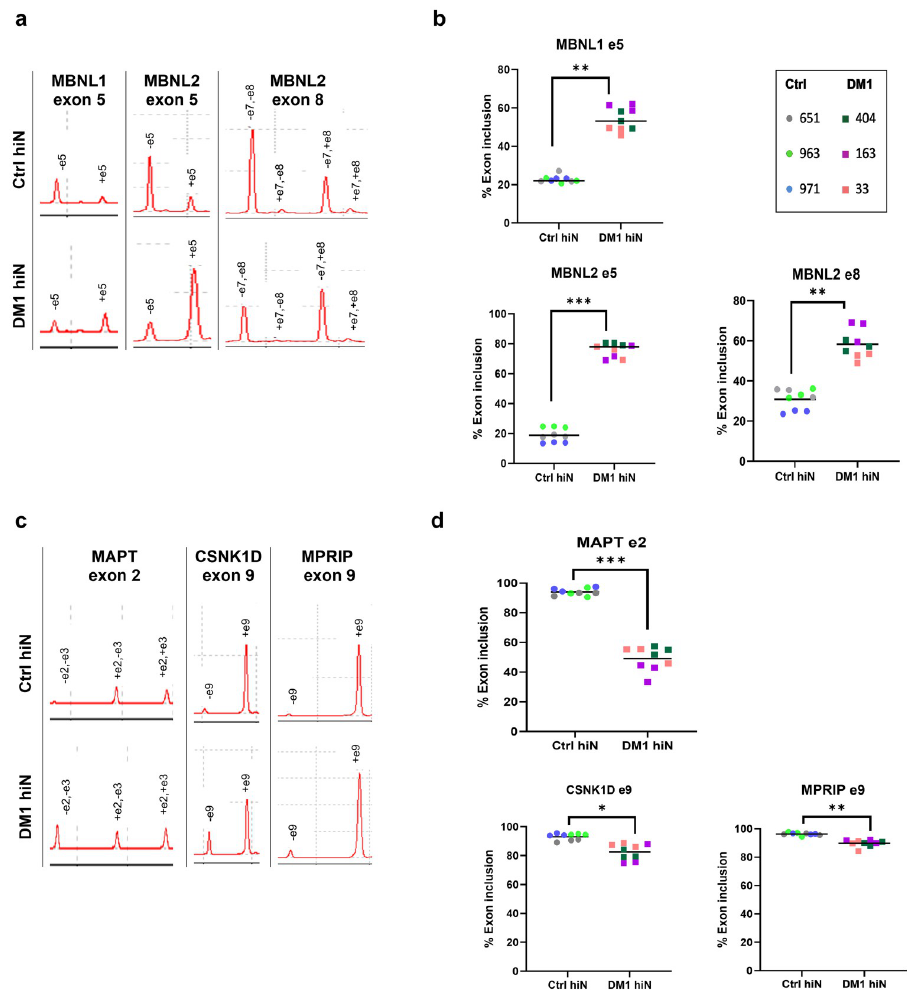
Fig 5. Dysregulated alternative splicing in DM1 hiNeurons at 10 DPI. (a) Electropherograms plot the results of RT-PCR products for MBNL 1 and 2 analyzed by MultiNA automated microchip electrophoresis system. Exon inclusion (+) or exclusion (-) of MBNL 1 e5 (left), MBNL 2 e5 (middle) and MBNL 2 e8 (right) in ctrl hiNeurons (top) vs. DM1 hiNeurons (bottom). (b) Scatter plots pertaining to Fig 5a show increased inclusion of MBNL 1 e5 (top), MBNL 2 e5 (bottom left) and MBNL 2 e8 (bottom right) in DM1 hiNeurons. (c) Electropherograms plot the results of RT-PCR products for some gene transcripts involved in neurite outgrowth. Exon inclusion (+) or exclusion (-) of MAPT e2 (left), CSNK1D e9 (middle) and MPRIP e9 (right) are shown. (d) Scatter plots pertaining to Fig 5c show decreased inclusion of MAPT e2 (top), CSNK1D e9 (bottom left) and MPRIP e9 (bottom right) in DM1 hiNeurons. DNA fragment sizes for each transcript are shown in S1 Table. n = 3 for each group. Each sample is presented in different color. Each symbol represents percentage of exon inclusion for one sample replicate. Line represents mean. Area under the peak was used for calculating percentage exon inclusion. � P < 0.05, �� P < 0.01 and ��� P < 0.001 compared to control group by unpaired t-test. RT-PCR, reverse transcriptase polymerase chain reaction; MBNL , muscleblind-like proteins; e, exon ; MAPT , microtubule associated protein tau; MPRIP , myosin phosphatase Rho interacting protein; CSNK1D , casein kinase 1